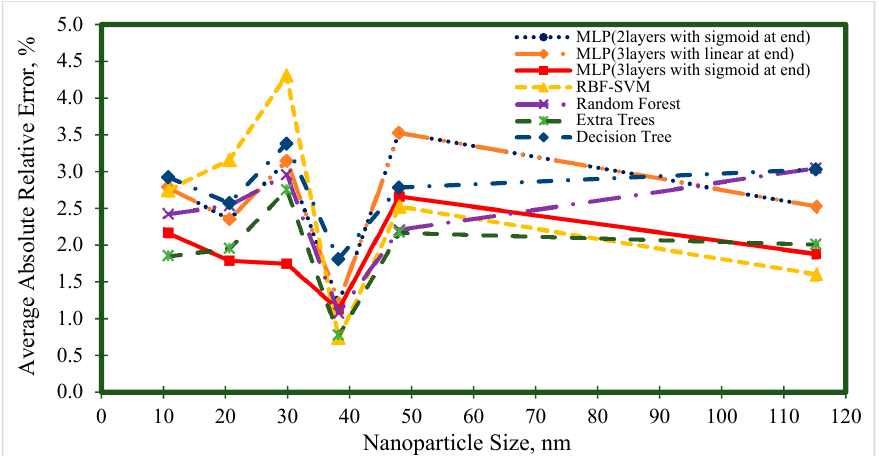
Figure 7. Average absolute relative error at different nanoparticle size ranges for prediction of the viscosity of nanofluids.